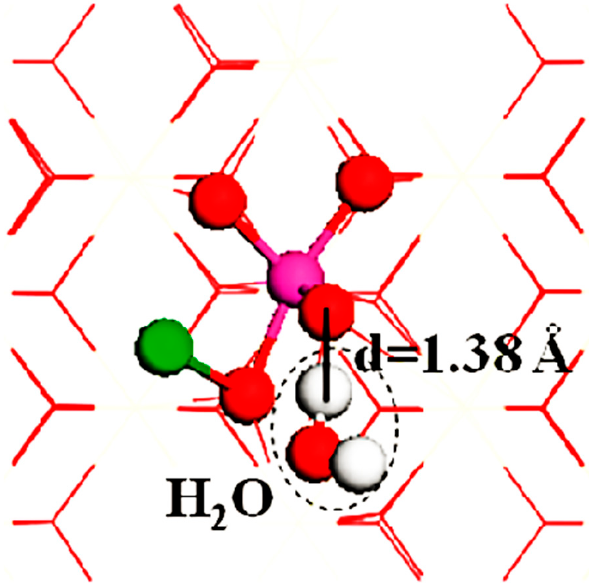
Figure 3. H 2 O adsorbed on the K-poisoned (110) catalyst surface [22].